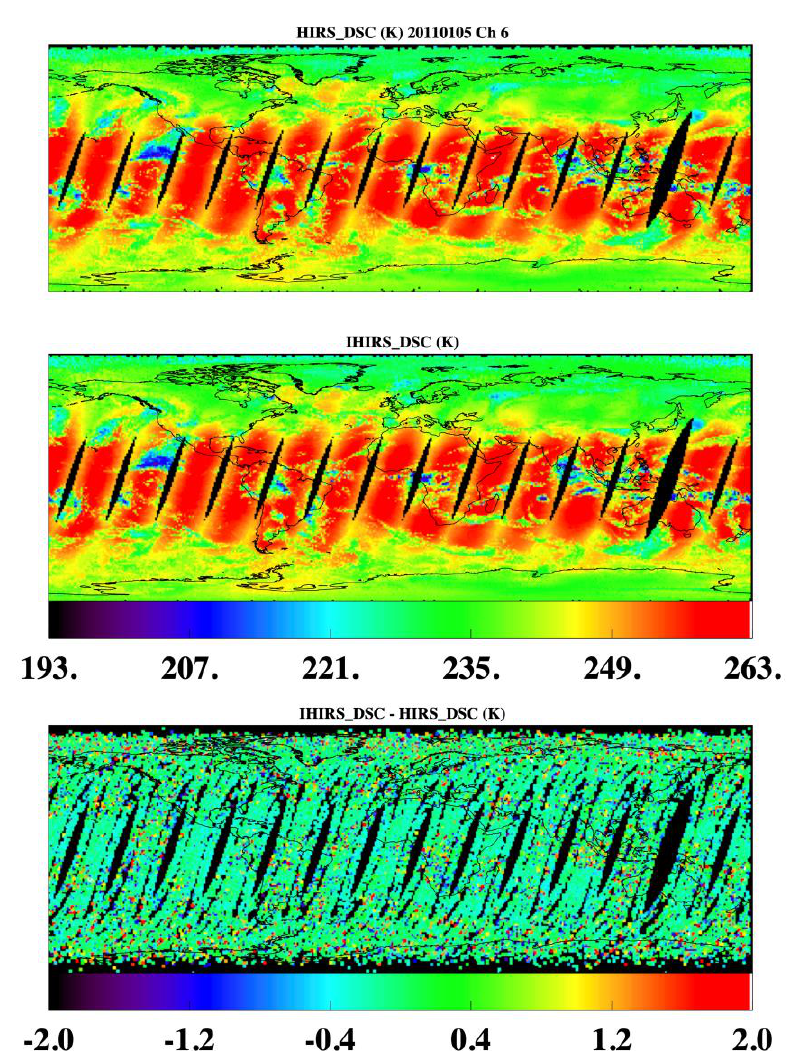
Figure 2. Spatial distribution of HIRS brightness temperature prior to limb correction for channel 6 for a sample day (5 January 2011) for descending orbits in the top panel, while the middle panel shows the same for the IASI-simulated HIRS (IHIRS_DSC) prior to applying the limb correction. The bottom panel is the difference (IHIRS_DSC-HIRS_DSC) for the descending orbits.